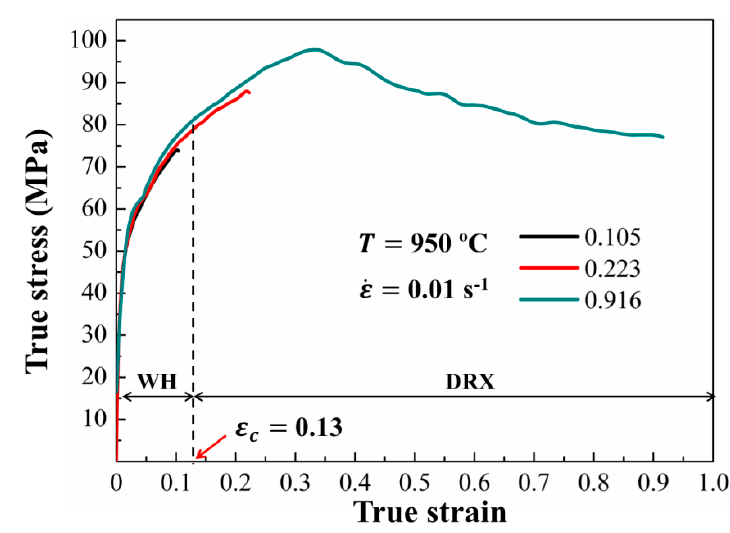
Figure 5. The true stress-true–strain curves at 950 °C and 0.01 s − 1 at different true strains.